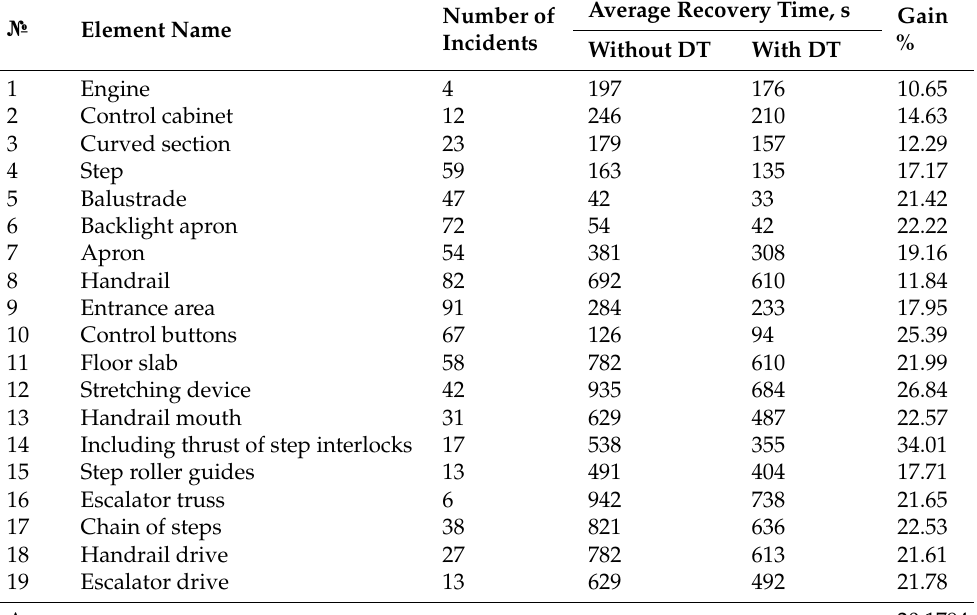
Figure 4. The structure of the intelligent video surveillance system. The video of the movement of people and the tape of the subway escalator were taken from open sources (YouTube, Yandex.Video, etc.) in full HD resolution (1920 × 1080), filmed on a Panasonic HC-V730 video camera, 24.0 megapixels deep. The accuracy of determining breakdowns of elements increased by 20%; more detailed information is given in Table 2 for each object. Table 2. Time required to repair breakdowns.